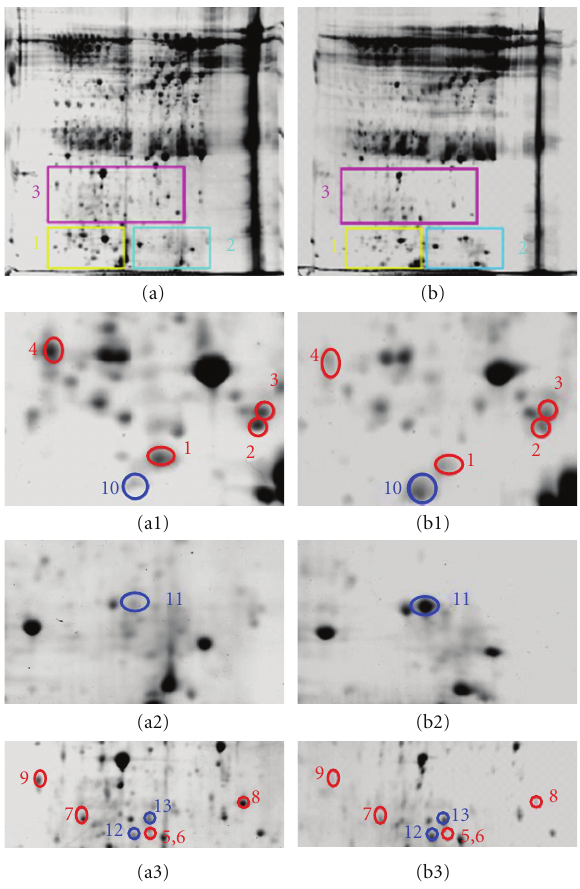
Figure 4: Analysis of di ff erent expressed spots after and before lung cancer formation (a), ((a1), (a2), (a3)) Serum electropherogram of lung cancer; (b), ((b1), (b2), (b3)) Serum electropherogram before lung cancer formation (correspond to (a)). The di ff erent expression of 13 protein spots was obvious. The red signed spots were the high- expressed protein spots and the blue signed spots were the low- expressed protein spots.